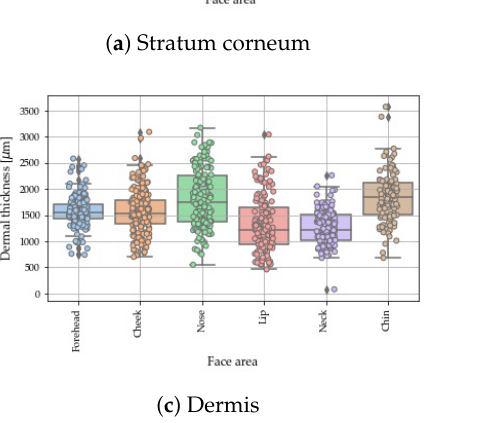
Figure 8. Box-plots/strip-plots of the thickness by skin layer and facial